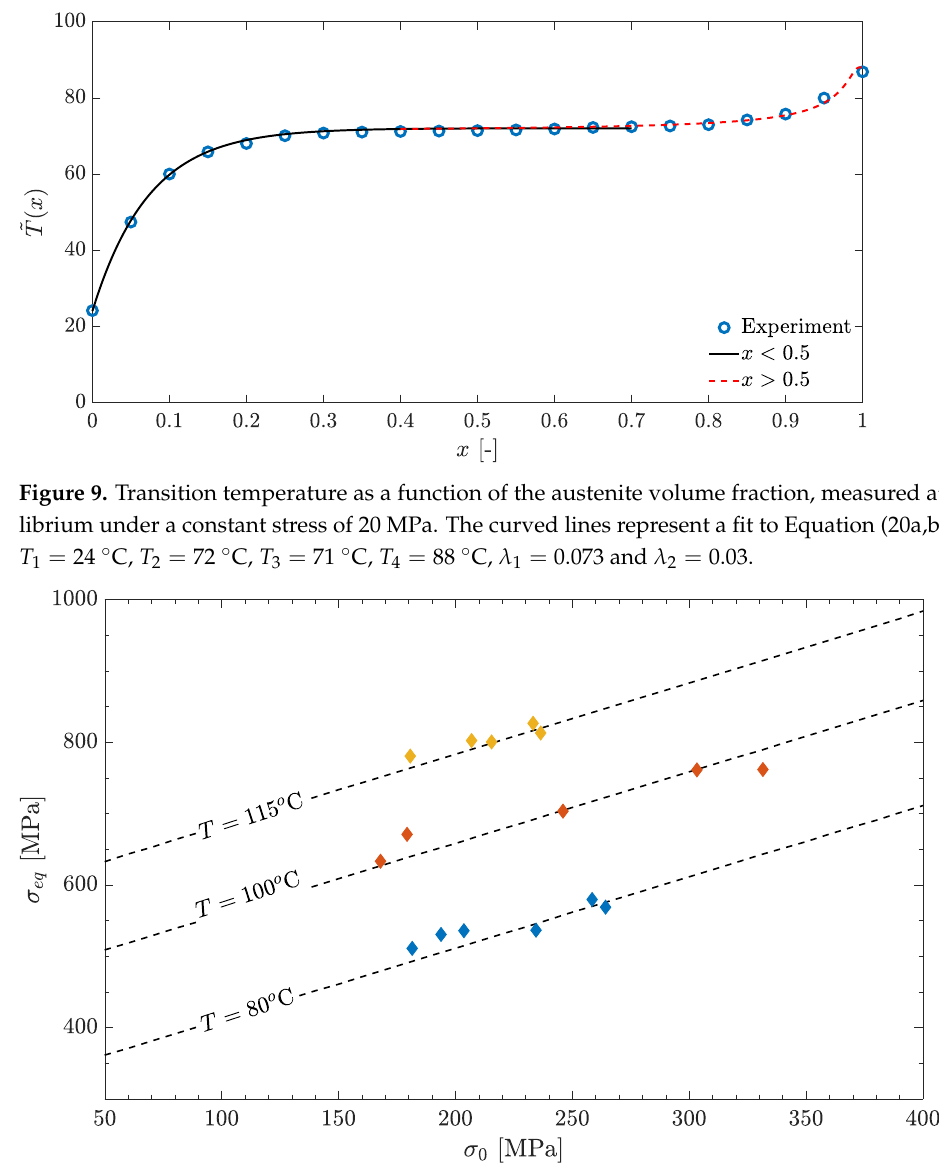
Figure 10. Measurements of the equilibrium stress, σ eq , under different applied initial stress values, σ 0 . The dashed lines represent calculations of σ eq as a function of σ 0 for constant T values, as indicated near each